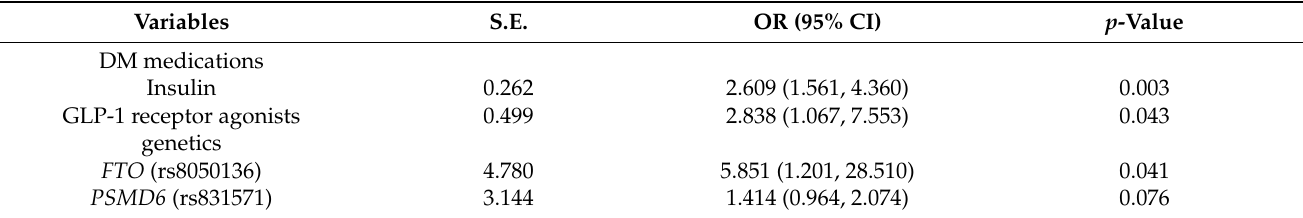
Table 4. Backward stepwise regression analysis on the association between SNPs rs8050136 and rs831571 on diabetic retinopathy risk using the recessive model, adjusted for DM medication